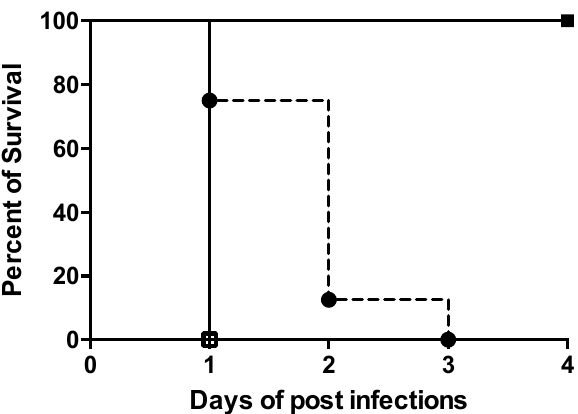
Figure 1. Percent of survival of A. baumannii -infected mice with 10 9 CFU / mouse ( (cid:3) ) 10 8 CFU / mouse ( (cid:8) ) or 10 7 CFU / mouse ( (cid:4) ).